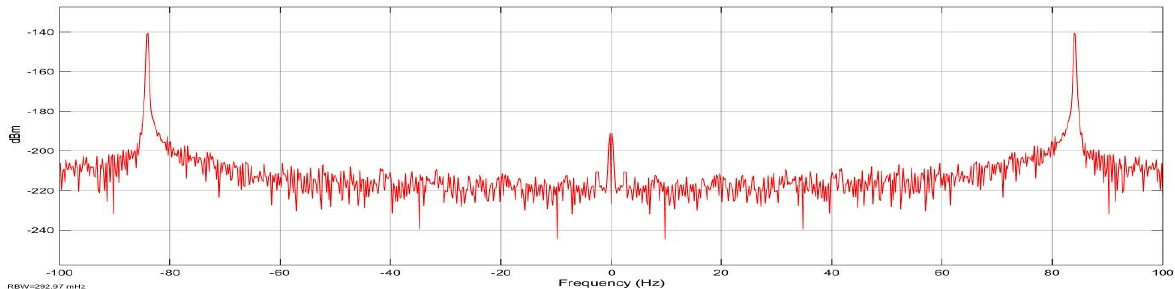
Fig. 5: Frequency Response of the Lateral Acceleration when Vehicle speed =10m/s and Conicity of Wheel =0.05